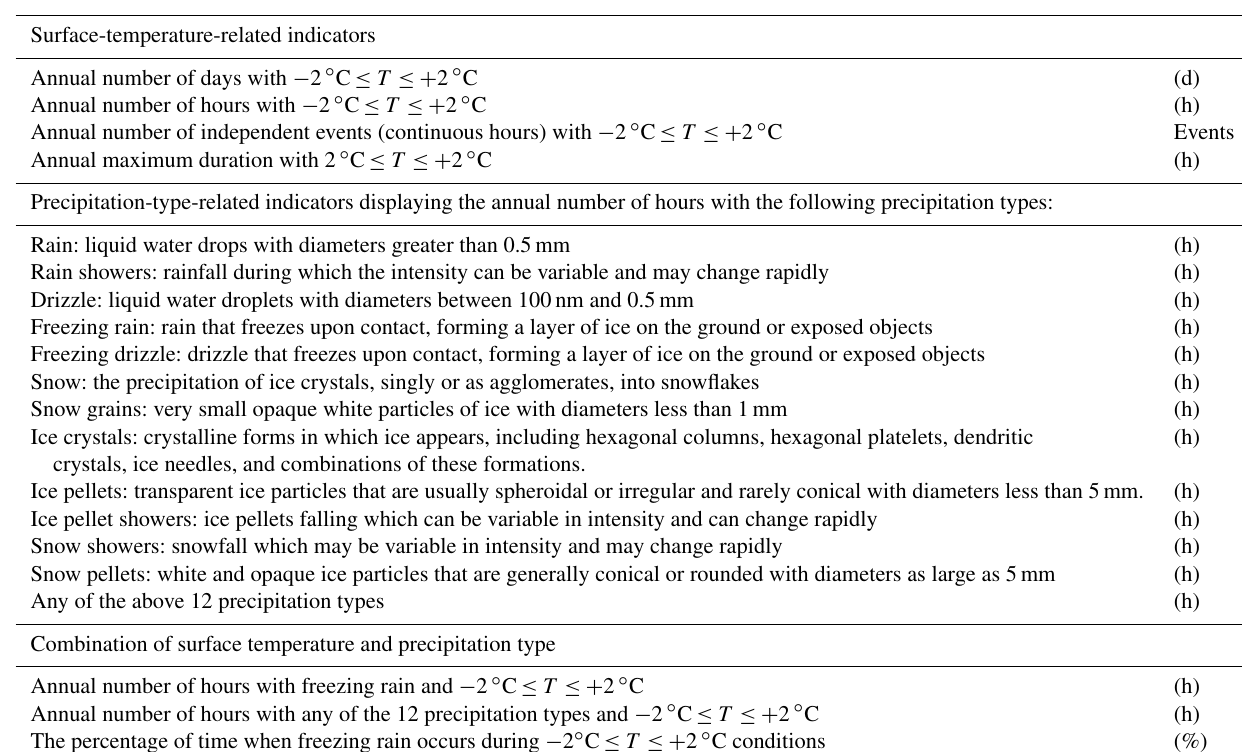
Table 1. Table of indicators in the − 2 ≤ T ≤ 2 ◦ C range. “ T ” refers to hourly surface dry bulb temperature, (d) represents days and (h) represents hours. Definitions were obtained from American Meteorological Society (2018), ECCC (2019b), and World Meteorological Or- ganization (2017). Definitions Unit Surface-temperature-related